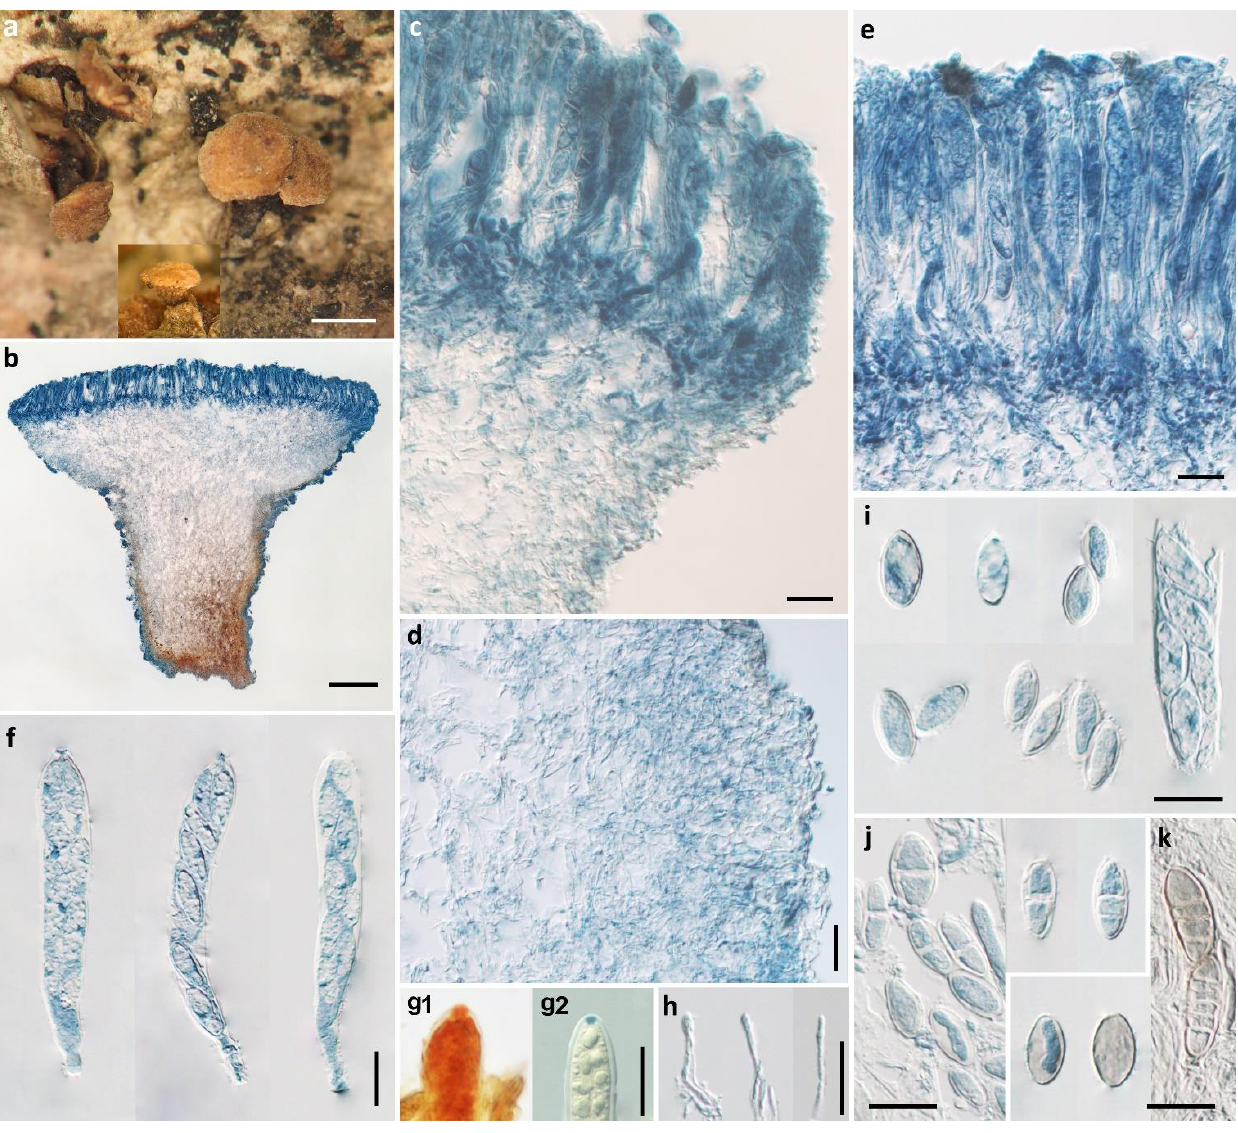
Figure 2. Pezicula ellipsoides H.D. Zheng & W.Y. Zhuang (HMAS 290888, holotype). ( a ) Dry apothecia on natural substrate; ( b ) longitudinal section of apothecium; ( c ) longitudinal section of apothecium (partial) showing excipular and hymenium structure at margin and upper flank; ( d ) excipular structure of stipe; ( e ) hymenium; ( f ) asci; ( g1 ) IKI reaction of ascus apical ring without KOH pretreatment; ( g2 ) IKI reaction of ascus apical ring after KOH pretreatment; ( h ) paraphyses; ( i ) ascospores; ( j ) ascospores with 0 – 1 septa; ( k ) light brown ascospores. Scale bars: ( a ) = 1 mm; ( b ) = 200 μm; ( c – k ) = 20 μm. Mounting media: ( b – f , h – k ) lactophenol cotton blue; ( g1 , g2 ) Lugol’s s olution. Apothecia erumpent, solitary or 2 – 3 on a basal stroma, discoid with surface convex, margin entire, short stipitate, 1 – 2 mm in diam; hymenium light yellow when fresh, pale brownish-yellow when dry; receptacle surface concolorous. Ectal excipulum of textura